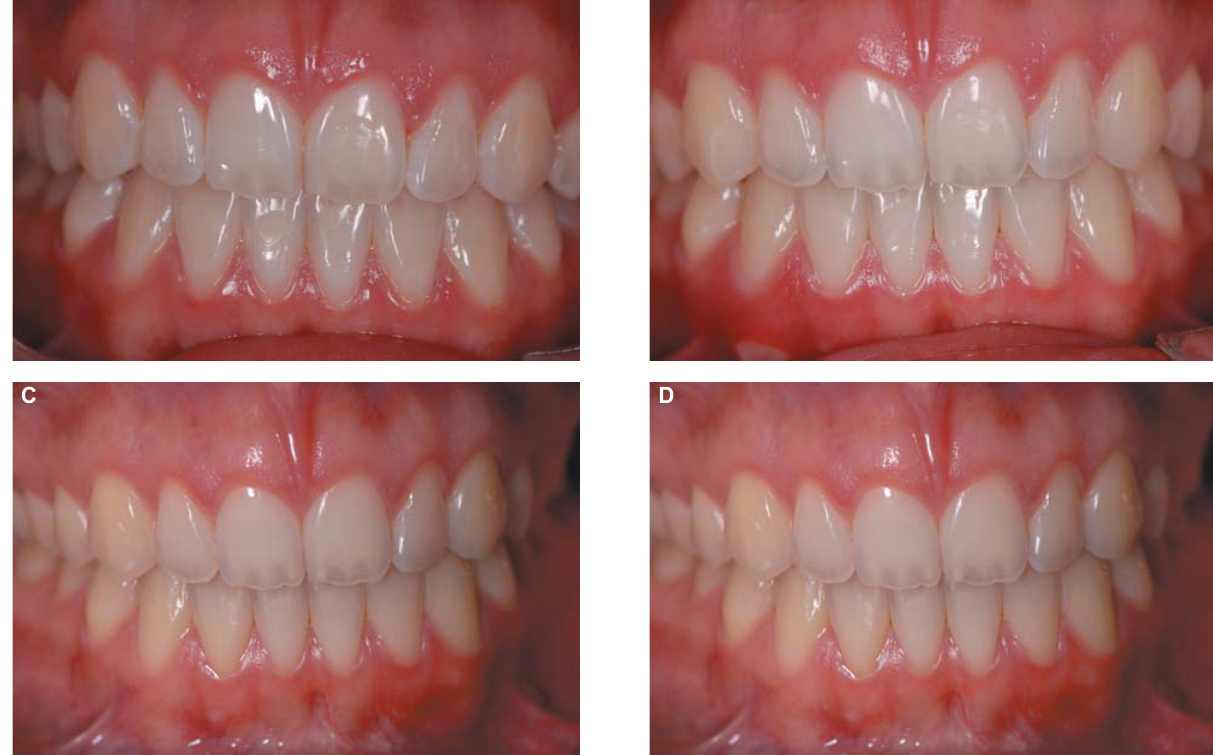
Figure 4- Control after: (A) 24 hours; (B) 1 month; (C) 12 months; (D) 24